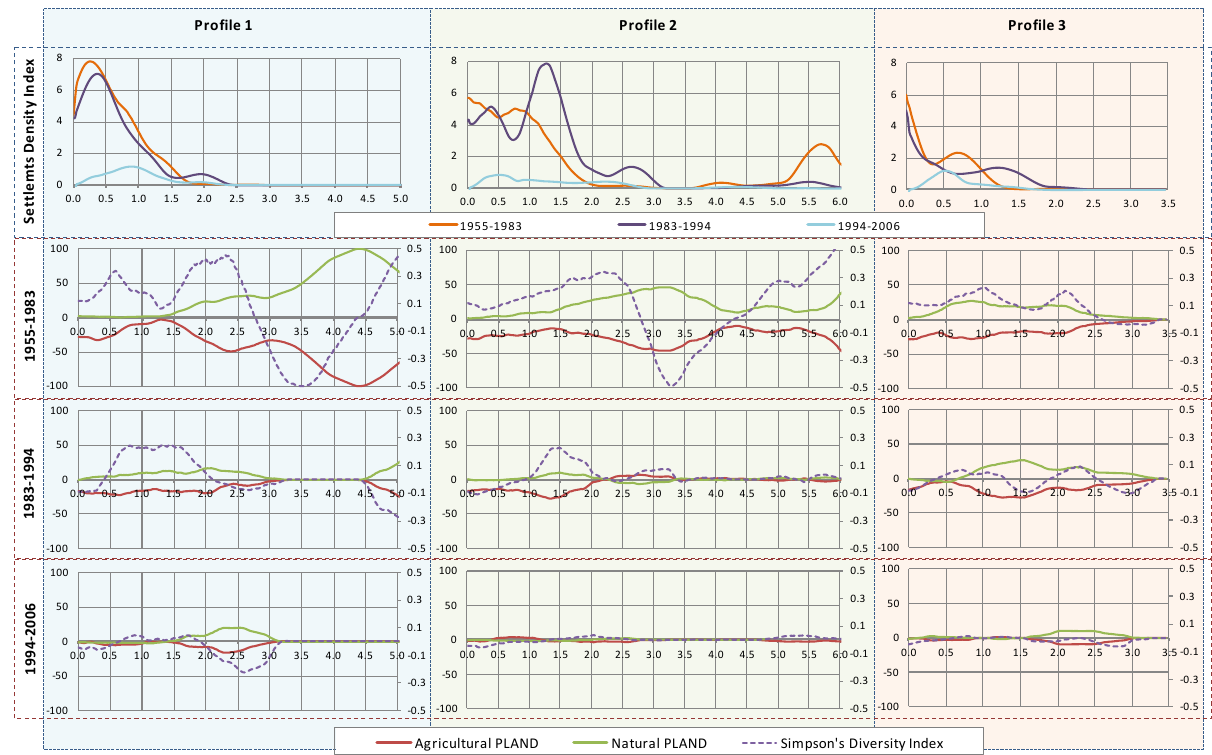
Fig. 14. Transformations of the urban–rural gradient measured along the landscape profiles (kilometres are shown on the x-axis). Spatial and temporal variations of Settlement Density Index (SDI), of agricultural and natural percentages of landscape (A-PLAND and N-PLAND) and of Simpson’s Diversity Index (SIDI). The latter is represented using the right graduation on the